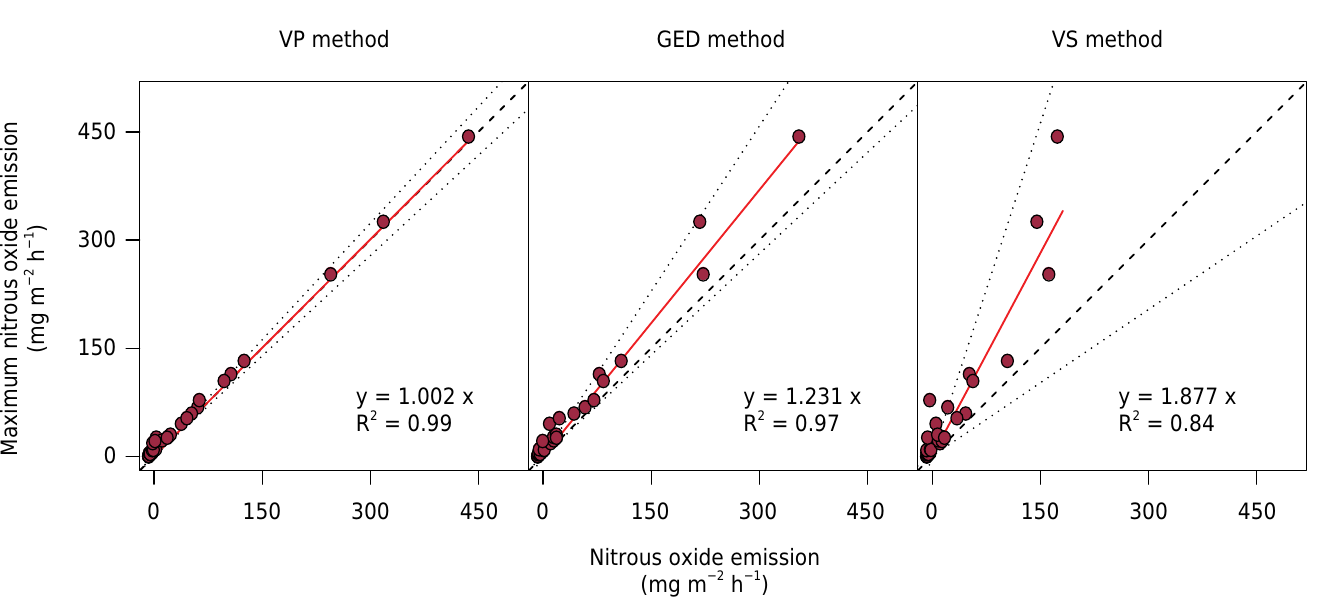
Figure 1. Relationship between maximum nitrous oxide emission and N-N 2 O emission by the Vacuum by Manual Pump (VP) method (left), Gas Exchange by Displacement (GED) method (middle) and the Vacuum by syringe (VS) method (right). The discontinuous line (---) represents the 1:1 relationship, the dashed lines (···) represent the relative RMSE and the red continuous line represents the adjustment of the assessed variables.